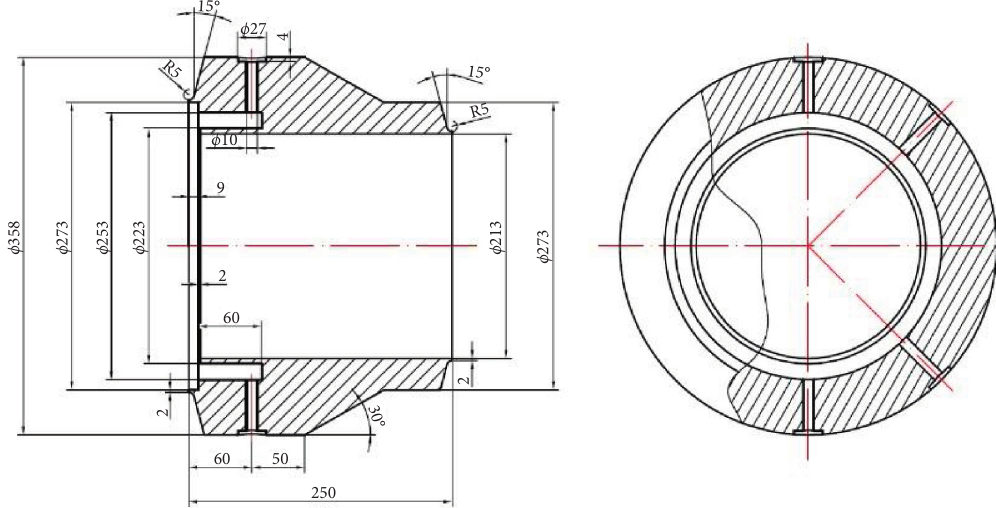
Figure 2: Measuring tube.